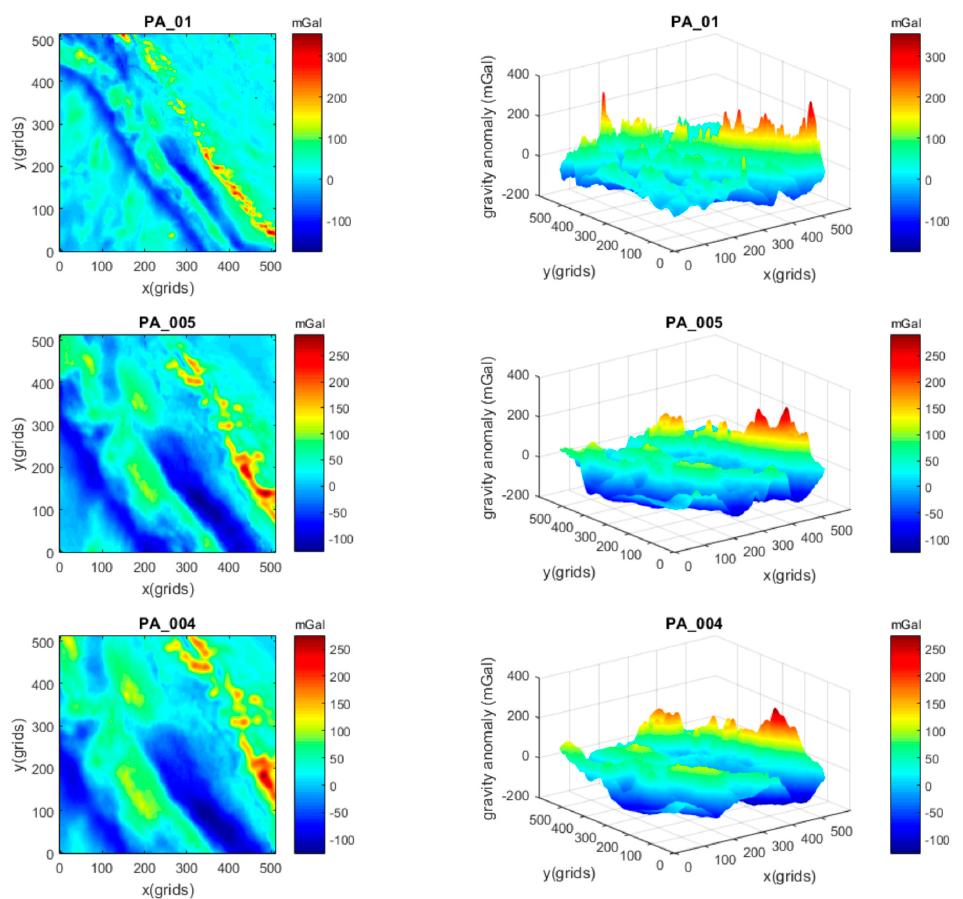
Figure 5. Gravity maps PA_01, PA_005, and PA_004.